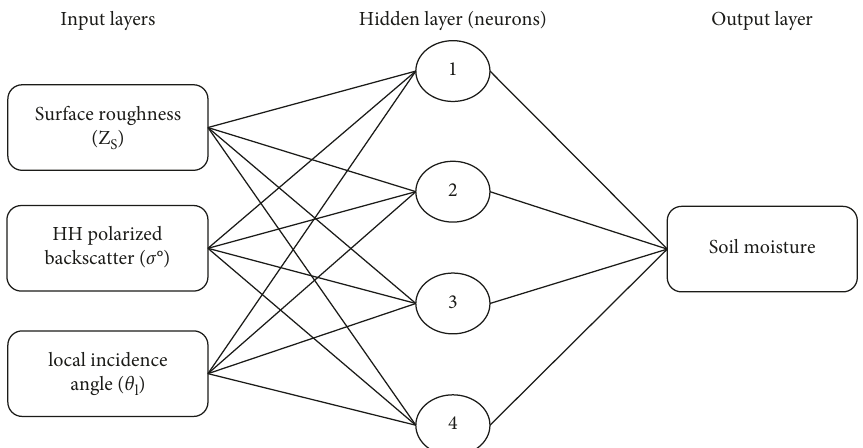
Figure 4: Schematic diagram of the spatially explicit input (and output) layers for the soil moisture ANN